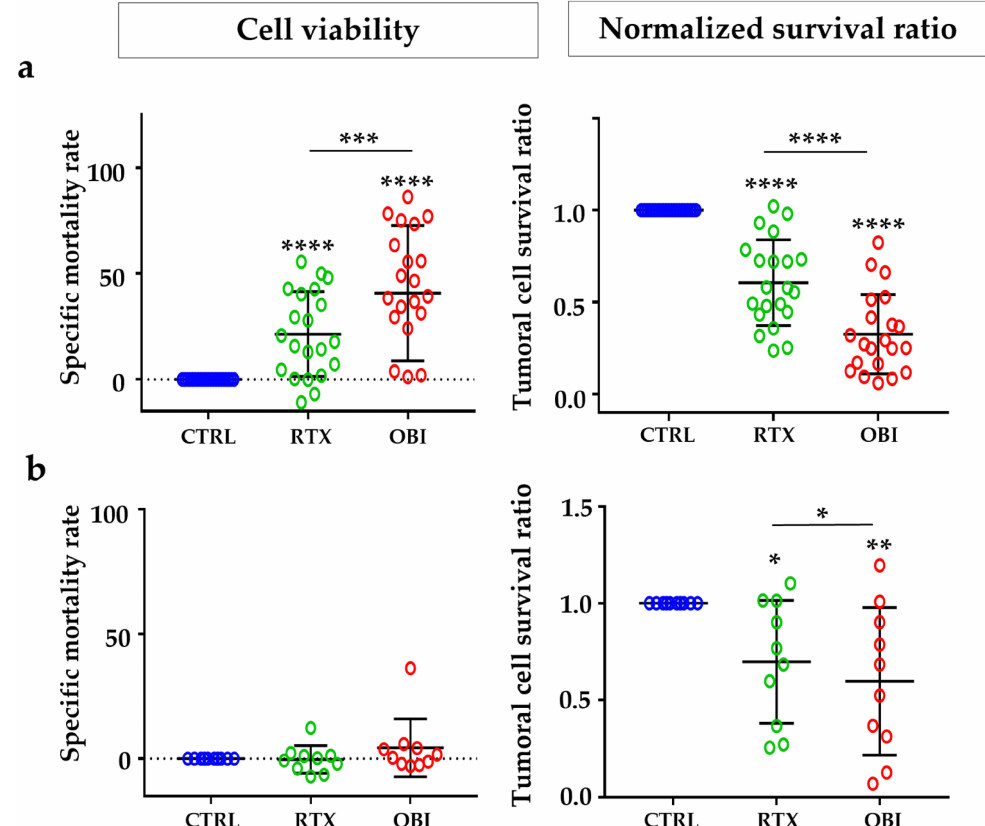
Figure 6. CD20 mAbs induced direct cell death on tumor cells from NHL and B-CLL patients. PBMCs from NHL ( a ) or B-CLL ( b ) patients at diagnosis were treated for 8 h with the depicted mAbs and tumor B cell death was examined by the method of cell viability (left) or normalized survival ratio (right) described in Figure S5. Each point represents one patient at diagnosis and performed in duplicate. Graphs show mean +/ − SD, of 21 and 10 patients for NHL or B-CLL, respectively; * p < 0.05, ** p < 0.01, *** p < 0.001, **** p < 0.0001; Tukey’s multiple comparisons test compared